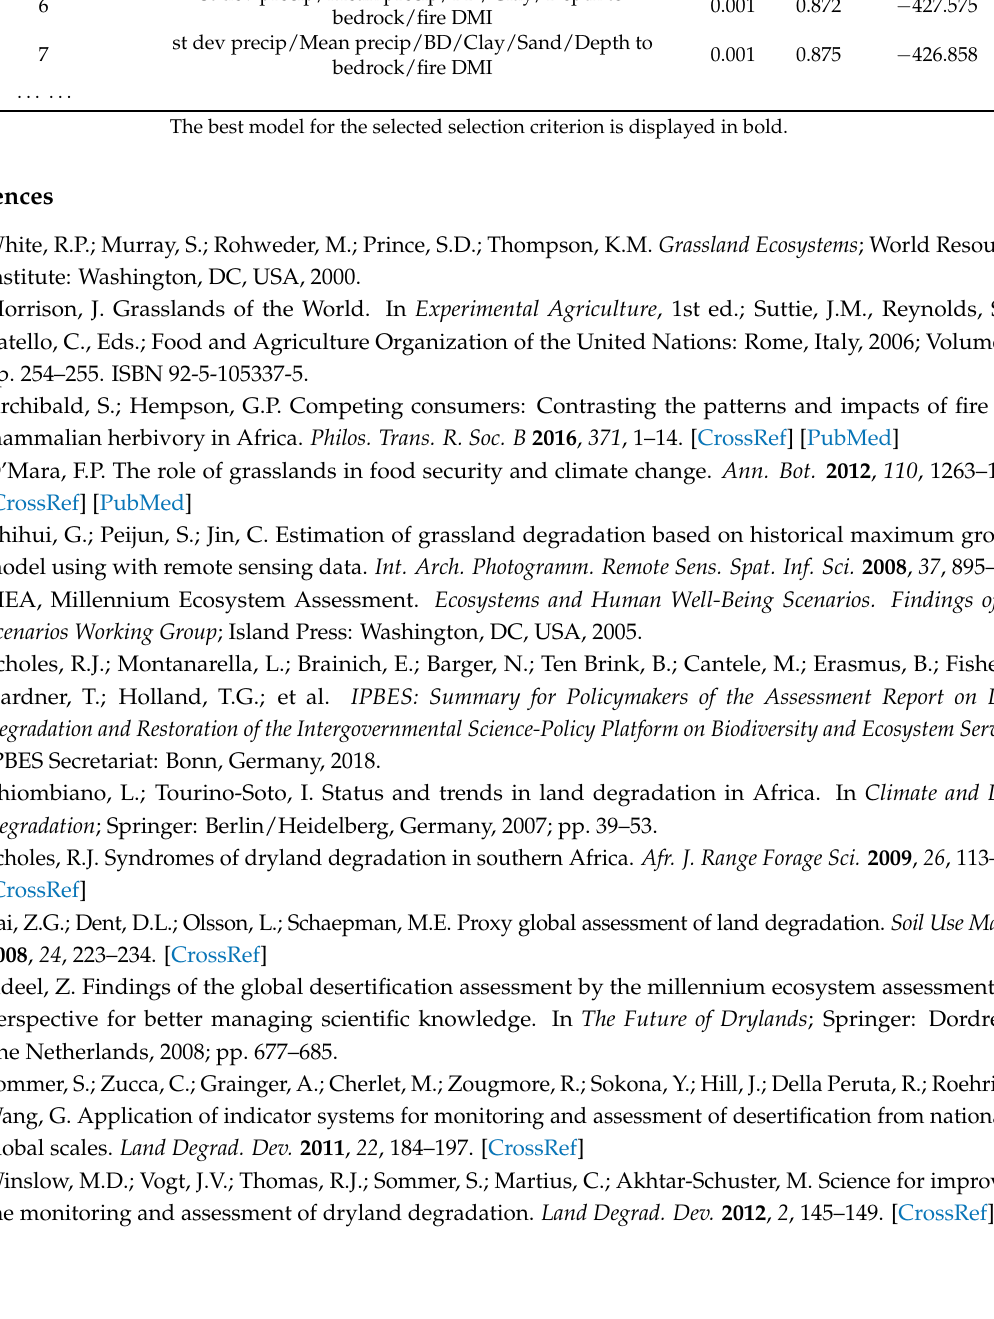
. . . . . . The best model for the selected selection criterion is displayed in